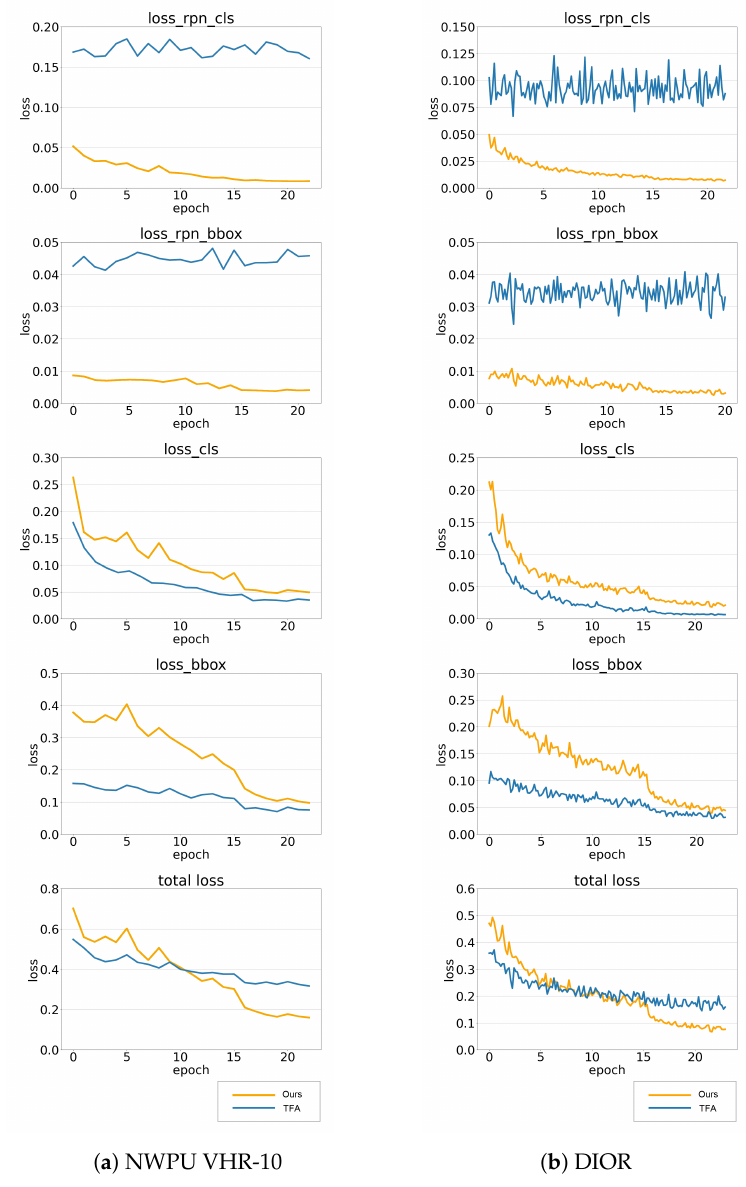
Figure 18. Loss curves of 10-shot models for NWPU VHR-10 and 20-shot models for DIOR. (From top to bottom: loss of classification in RPN, loss of localization in RPN, loss of classification in fast R-CNN, loss of localization in fast R-CNN, and total